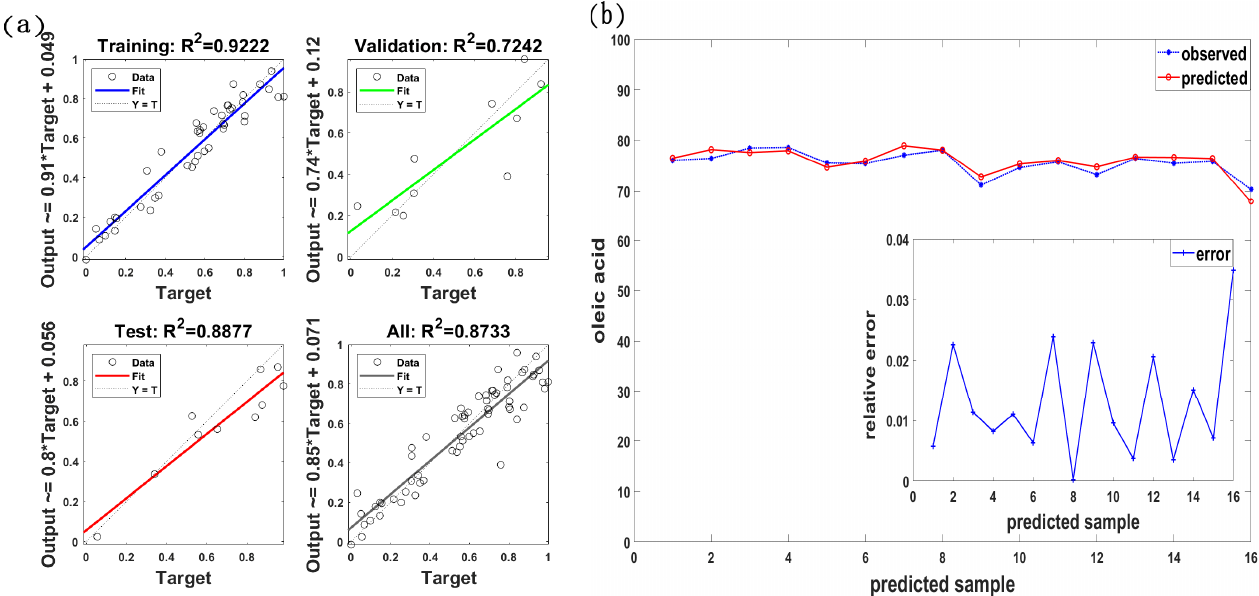
Figure 5. Model results obtained from the quaternary combination {MF- h (0), SB-DR 574 , TriP-SDr, SPI-NDSI( R 575 , R 576 )}. ( a ) is for the 64 training samples. ( b ) is for the 16 testing samples. Table 6. The influence of MF parameters on model